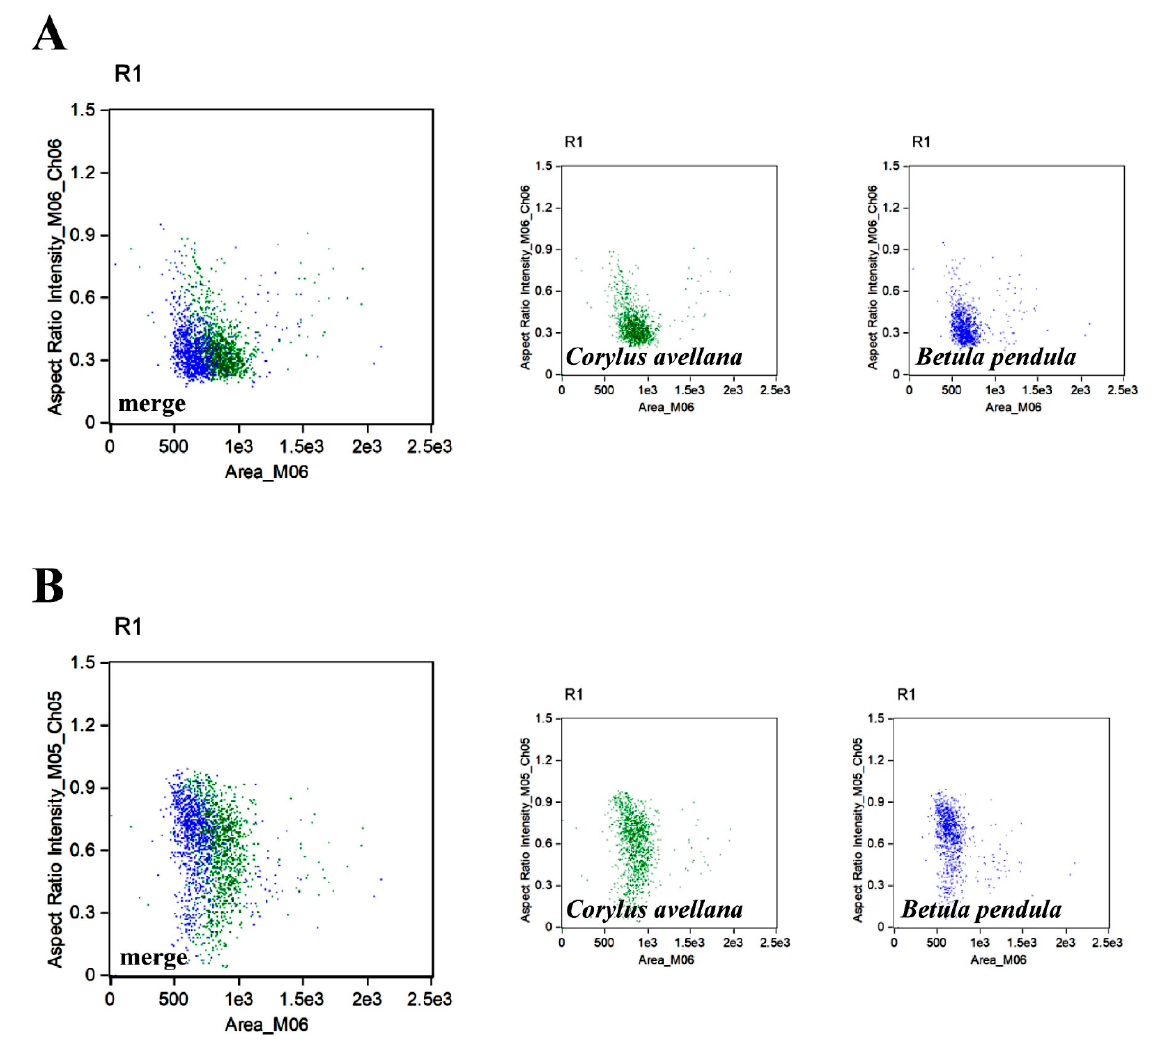
Figure 7. Colocalisation analysis Corylus avellana population (green) with Betula pendula population (navy blue) using IFC. Due to the close colocalisation of these species (Figure 6), additional parameters were considered, namely the ‘aspect ratio intensity’ parameter in channel 6 (SSC, y -axis) versus the ‘area’ parameter (channel 6, SSC, x -axis) ( A ) and the ‘aspect ratio intensity’ parameter in channel 5 ( y -axis) versus the ‘area’ parameter (channel 6, SSC, x -axis) ( B ). Separate and merged profiles are